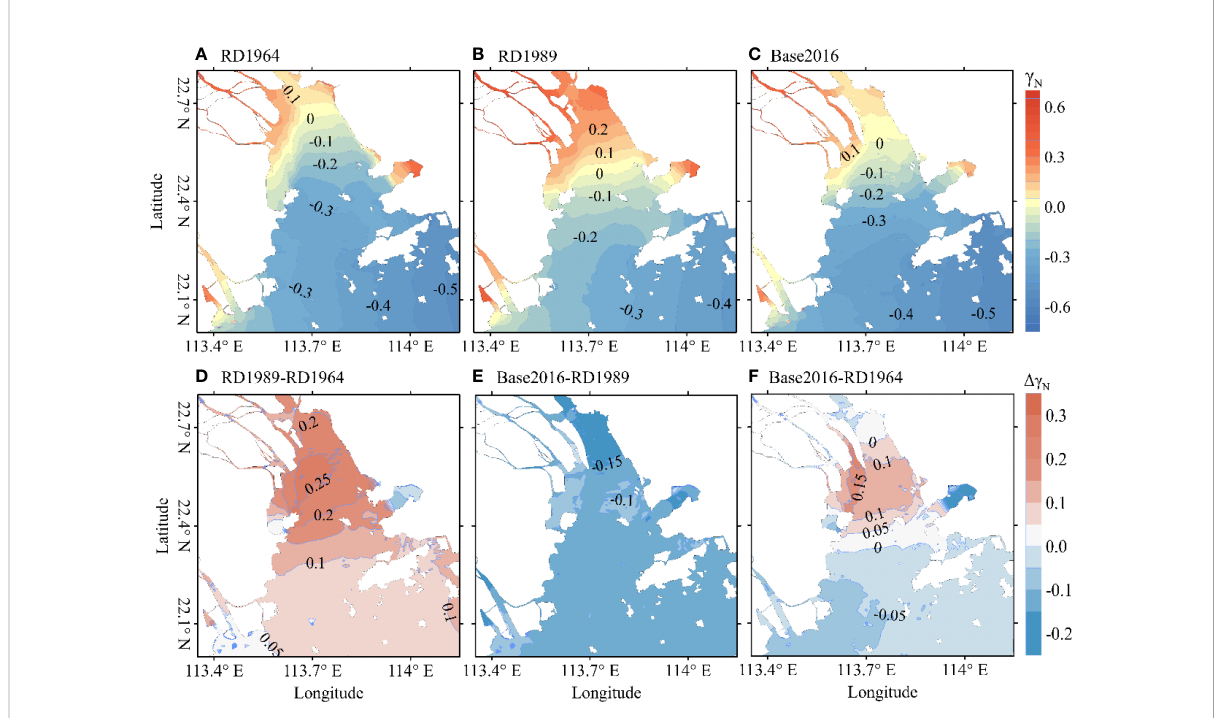
FIGURE 4 Contour map of tidal skewness for the different scenarios; (A – C) denotes the case of RD1964, RD1989, and Base2016, respectively. Contour map of the difference between two scenarios, including RD1989-RD1964 (D) , Base2016-RD1989 (E) , and Base2016-RD1964 (F) . Panels (D) and (E) show the stepwise changes of tidal skewness in response to morphological evolutions, whereas panel (F) shows the cumulative effect of morphological change between 1964 and 2014 on tidal